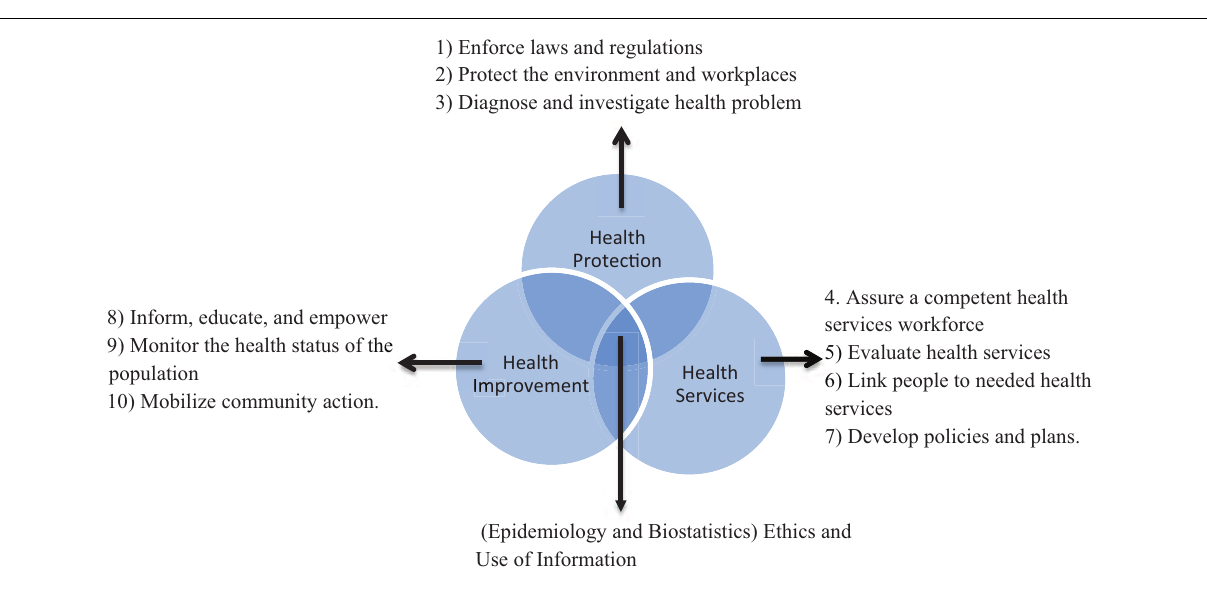
FIGURE 1 |The 3 domains and 10 activities of public health practice . Modified from Ref.